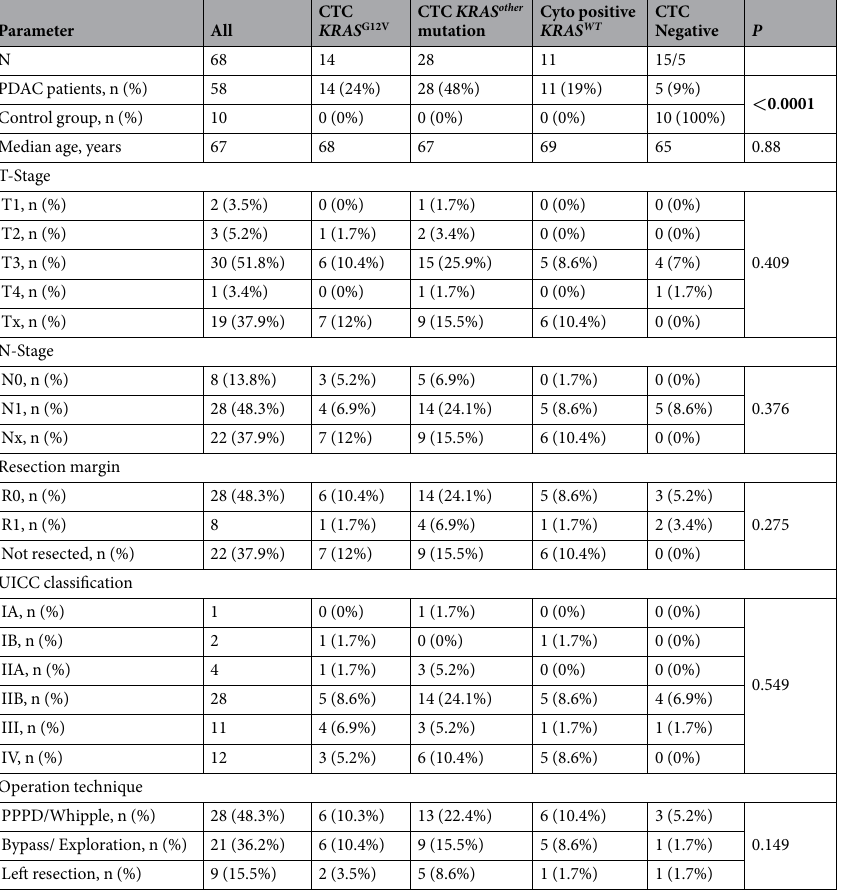
Table 1. Demographics, tumor characteristics, circulating epithelial cell status, and median survival of patients with PDAC (n = 58) and control patients (n = 10). UICC Union international contre le cancer, n . s . not